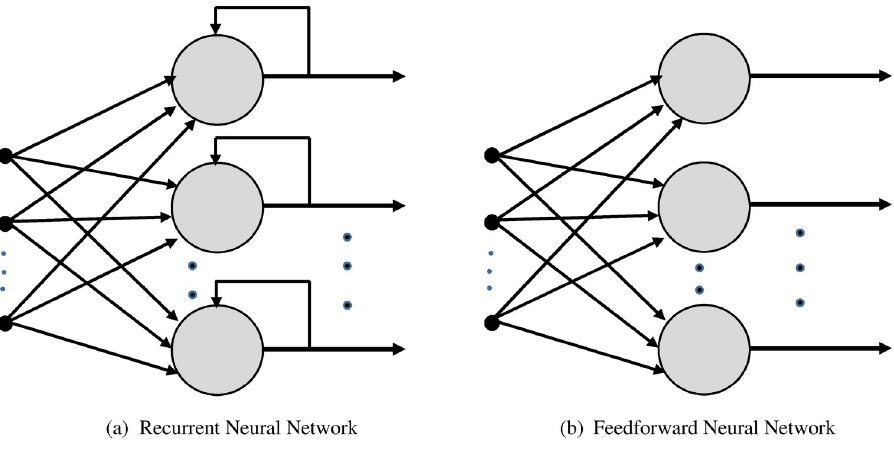
Fig 2. An architecture of recurrent and feedforward neural networks. (a) Recurrent Neural Network, (b) Feedforward Neural